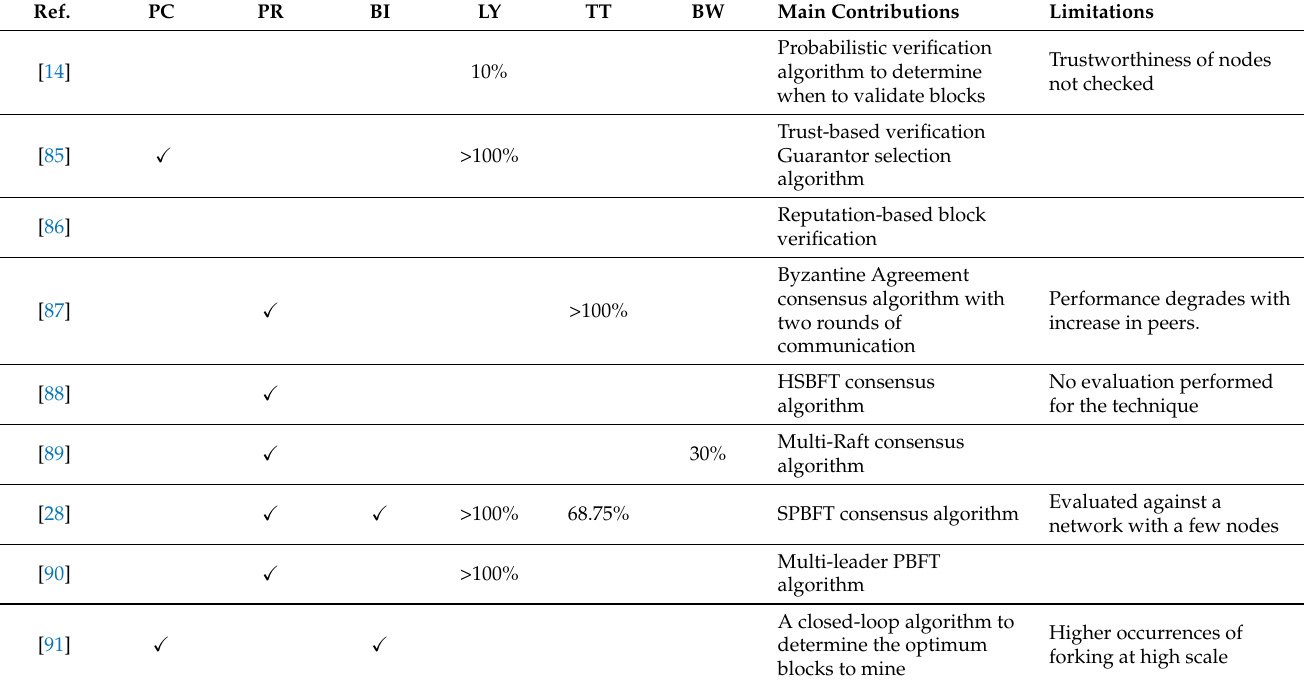
Table 7. Comparison of Consensus Layer Techniques. PC = Public Blockchain, PR =